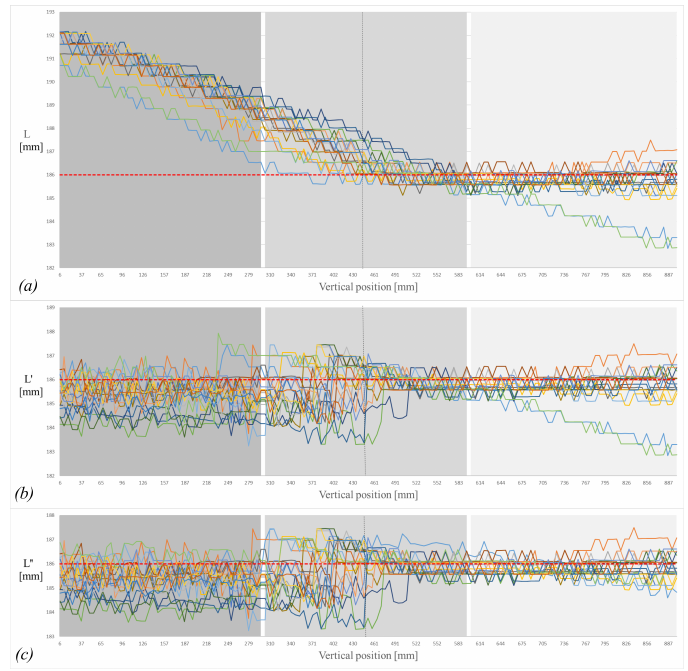
Figure 6. ( a ) Measured length without correction; ( b ) measured length with perspective correction; ( c ) measured length with tilt correction. Note that different colors represent each drop with length measurements of the falling cylinder.